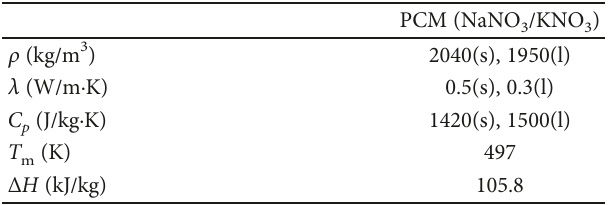
Figure 1: Schematic diagram of a truncated cone shell-and-tube TES model. Table 1: Thermophysical properties of